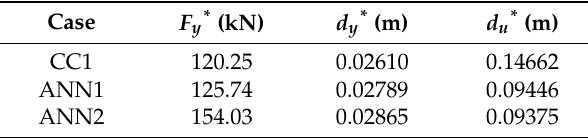
Table 5. Results obtained for the control case n. 1.